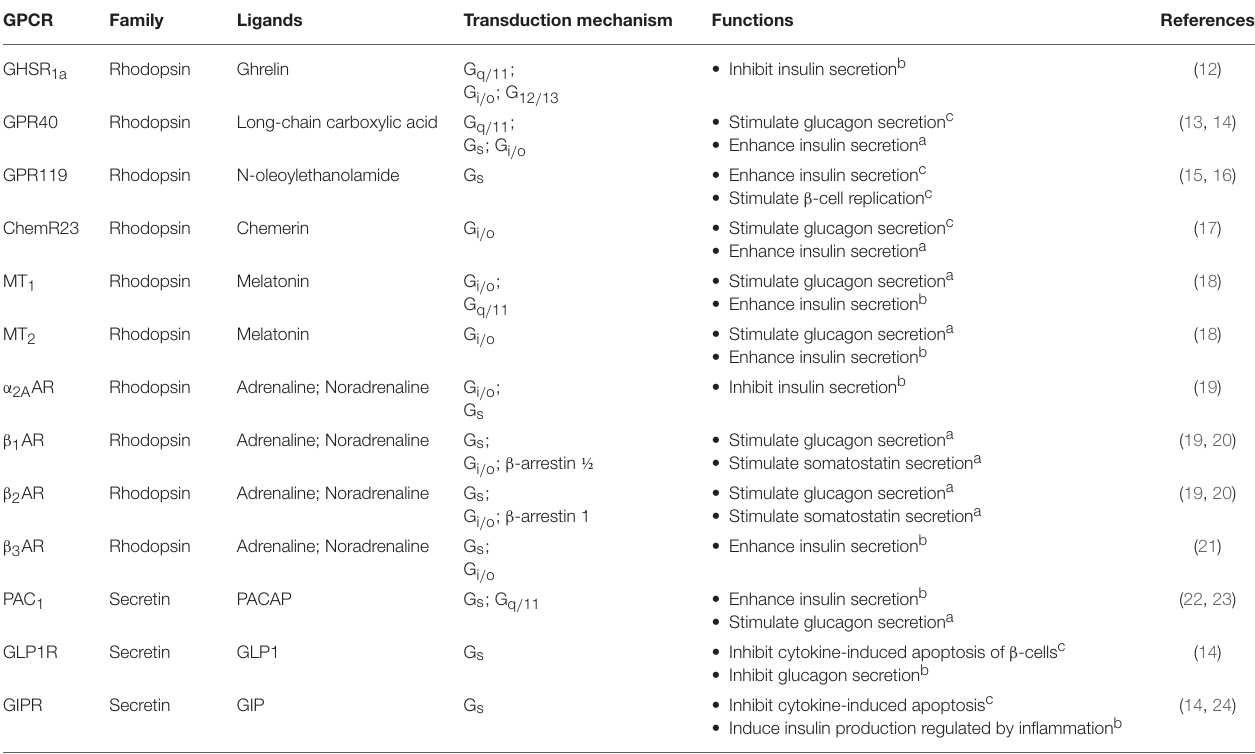
TABLE 1 | Examples of GPCRs in the pancreatic islet for receiving circulatory inputs.